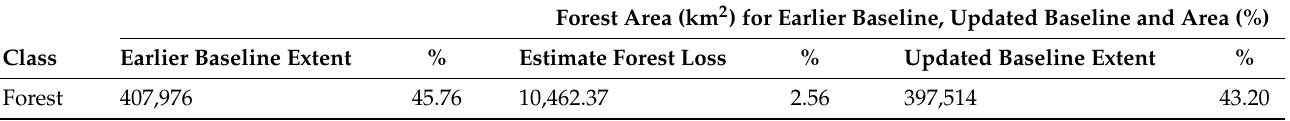
Table 17. Update of forest baseline extent from the detected forest loss for the period 2013–2019. Forest Area (km 2 ) for Earlier Baseline, Updated Baseline and Area